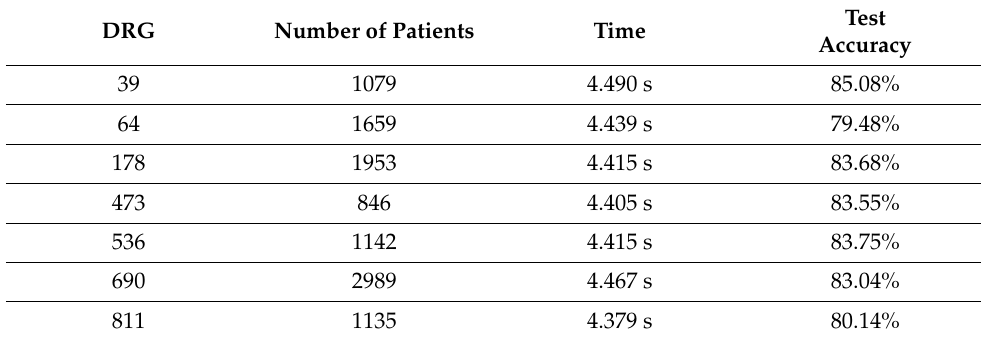
Table 2. DNN Sequential Neural Network results on DRG billing